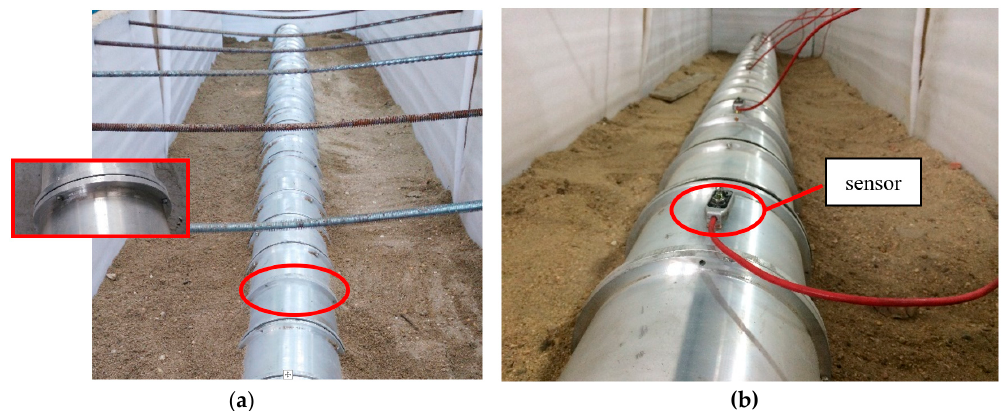
Figure 2. Experimental setup for dynamic tests of aluminum pipe model.